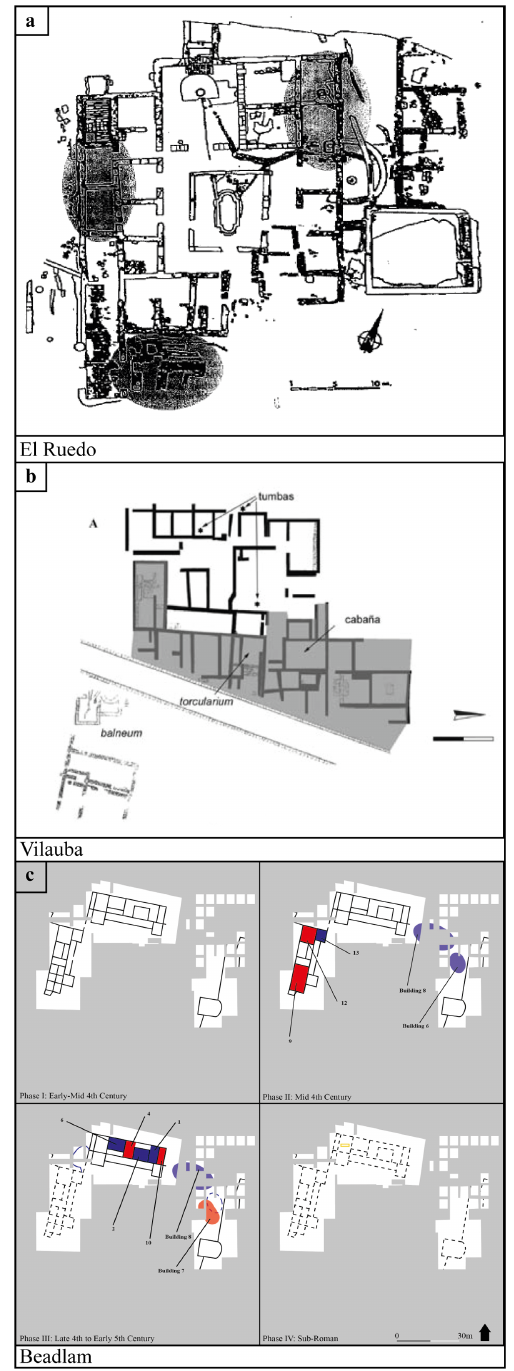
Figure 1: Three examples of previous attempts to display transformational data at villa complexes: a. El Ruedo (Lewit 2005: 252, Fig. 1, reproduced with permission of Cambridge University Press), b. Vilauba (Chavarría 2007: 171, Fig. 35, reproduced with kind permission of Quim Tremoleda Trilla), c. Beadlam (Dodd